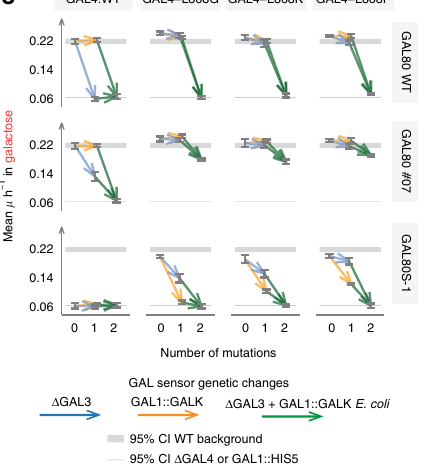
Pseudo−log10 GAL1 pr-YFP fluorescence intensity, A.U.